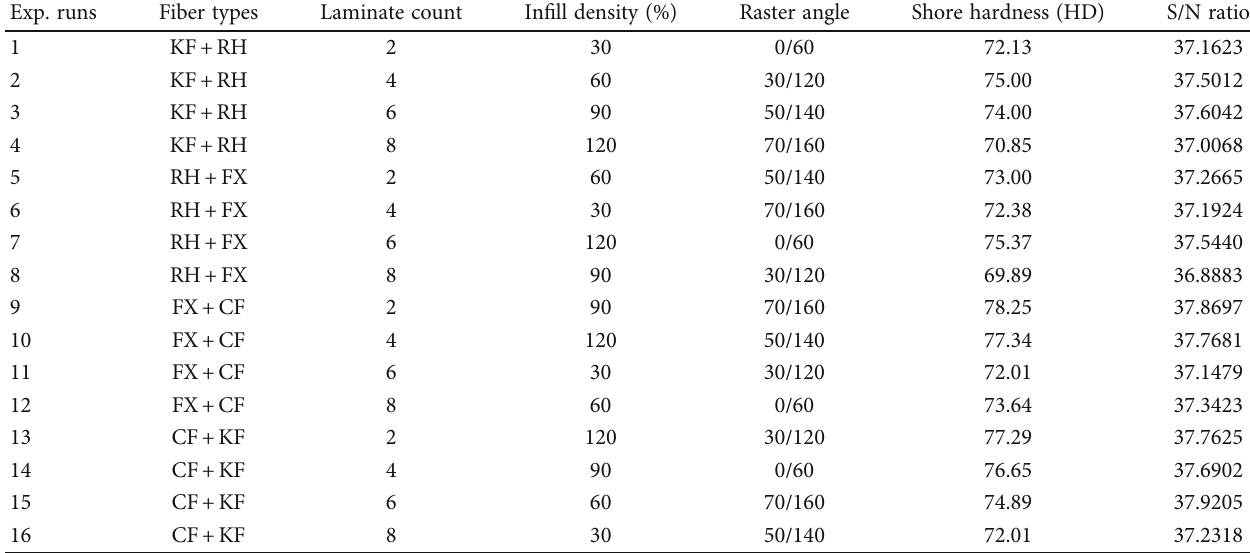
Table 6: Summary of shore hardness and in fl uence of input parameters. Exp. runs